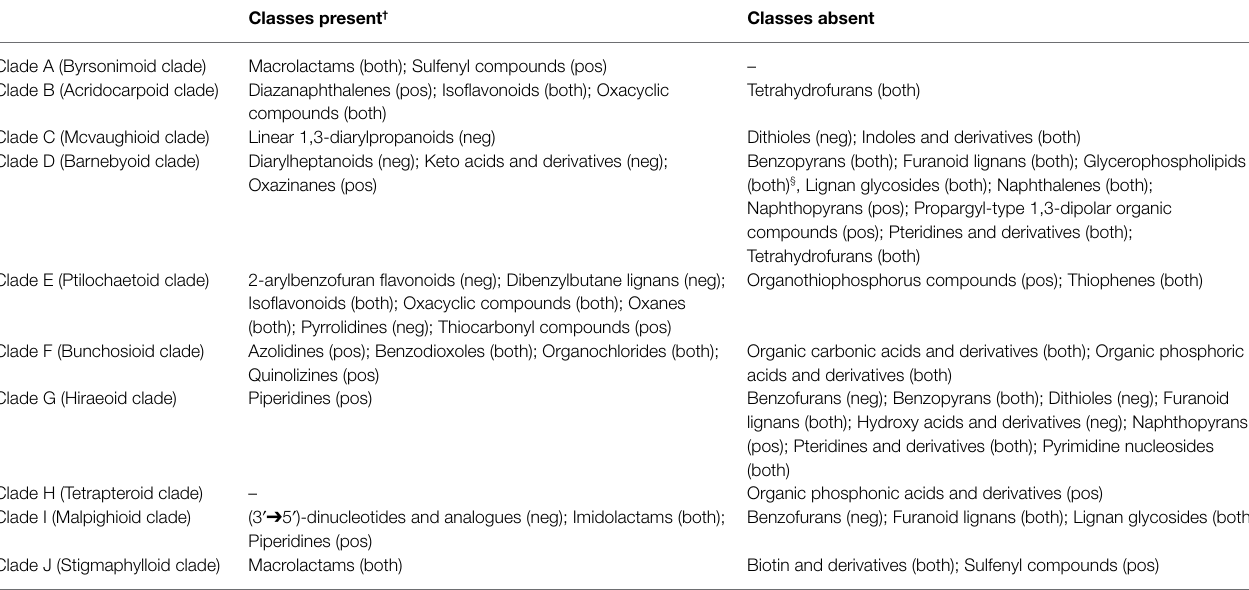
TABLE 1 | Characters retrieved from the ancestral characters reconstruction (clades) based on the classifications obtained in silico for Malpighiaceae samples. Classes present † Classes absent Clade A (Byrsonimoid clade) Macrolactams (both); Sulfenyl compounds